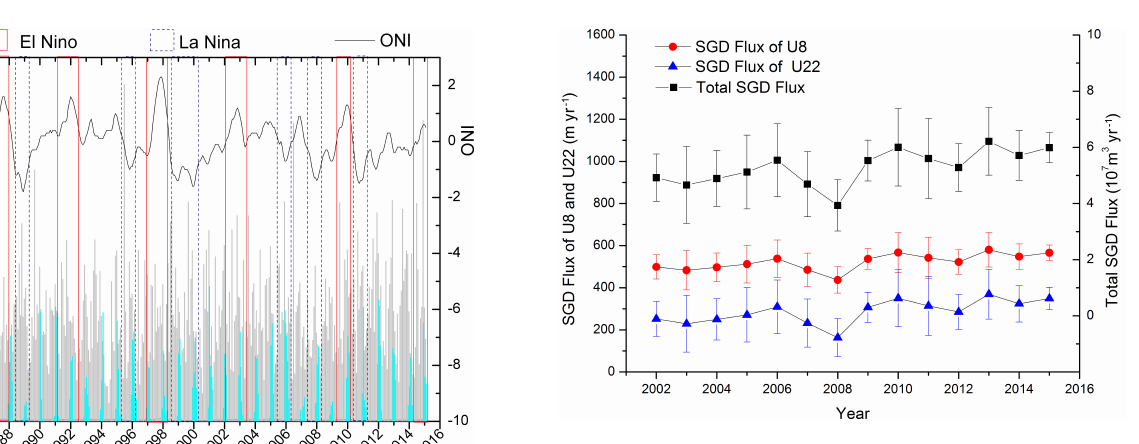
Figure 5. Estimated SGD flux by groundwater